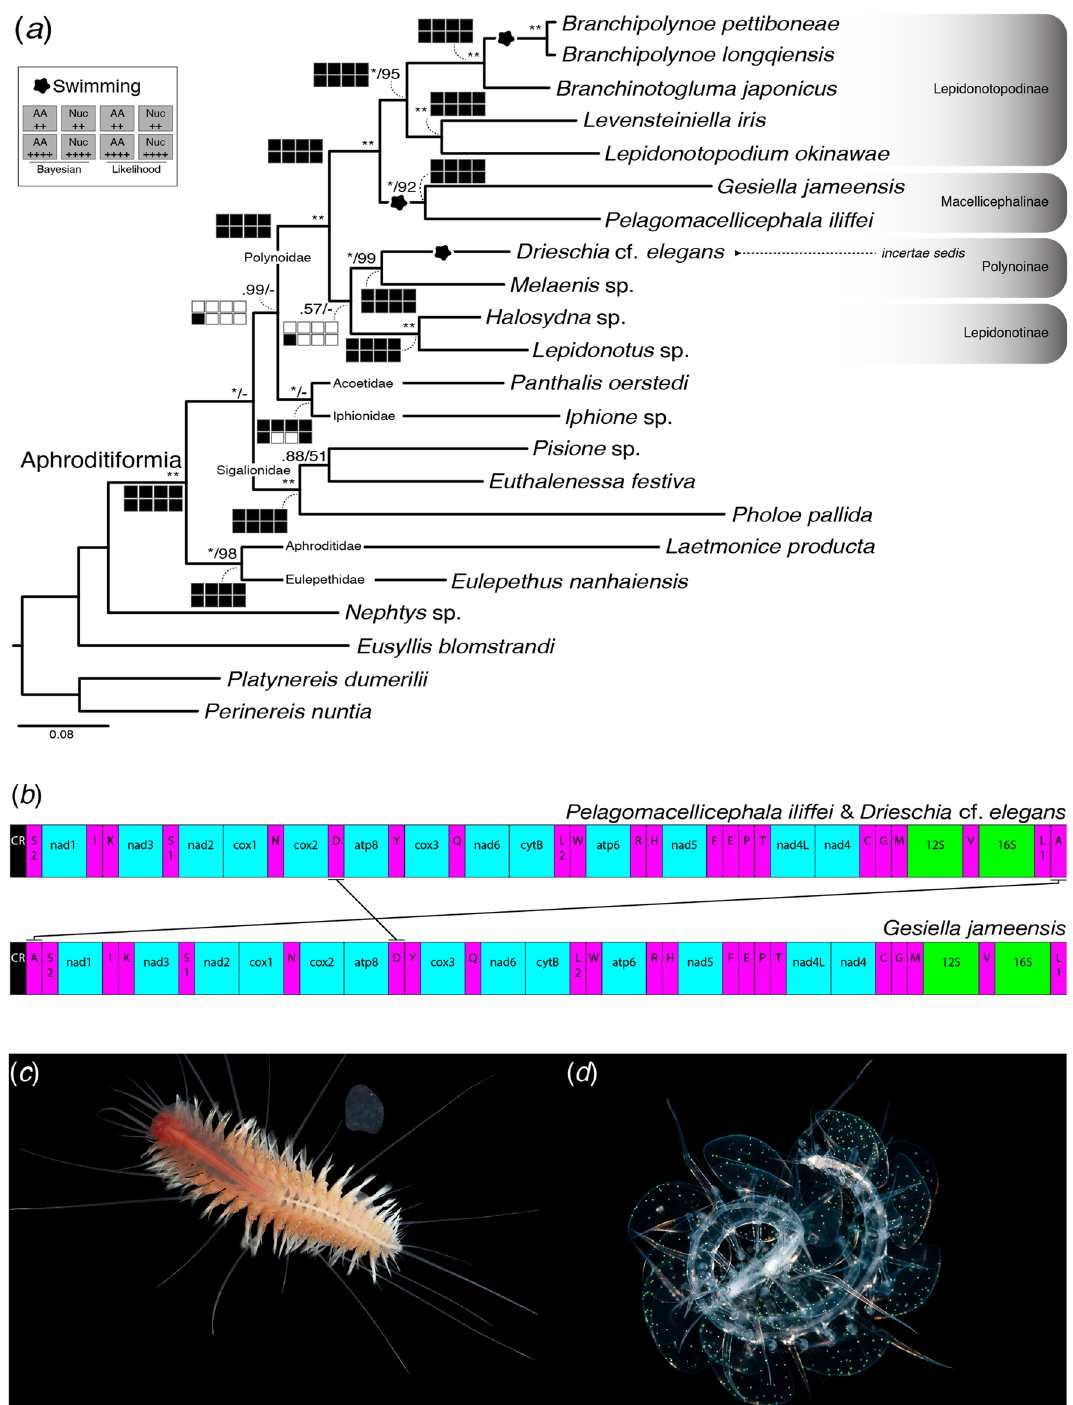
Figure 1. Mitogenomic analyses of Aphroditiformia. ( a ) Mitogenome relationships of Aphroditiformia based on the concatenated dataset of 13 protein coding genes translated into AA + 12S + 16S + 18S + 28S. Tree topology based on the Bayesian analysis (BA) of the dataset. Only nodal support above BPP = 0.5 and MLB = 50 are displayed. Nodes not recovered across analyses or with support lower than BPP = 0.5 and MLB = 50 are represented by a dash (–). Asterisks (*) denote BPP = 1.0 or MLB = 100. “Navajo rugs” indicate recovered (black squares) and unrecovered (white squares) nodes for each of the datasets across both BA and ML. Abbreviations: AA++, 13 PCGs translated into AA + 12S + 16S; AA++++, 13 PCGs translated into AA + 12S + 16S + 18S + 28S; Nuc++, 13 PCG (nucleotides) + 12S + 16S; Nuc++++, 13 PCG (nucleotides) + 12S + 16S + 18S + 28S. ( b ) Mitochondrial gene orders across the three newly generated mitogenomes. Gene order of Pelagomacellicephala iliffei and Drieschia cf. elegans follow that of the putative Polynoidae ground pattern. Black lines indicate the location and direction of gene rearrangements as indicated by the software CRExy 63 . Putative location of the control region (CR) is indicated by black filled rectangles, while fuchsia rectangles indicate tRNA’s, turquoise for PCGs and green for mt rRNAs. ( c ) Cave Pelagomacellicephala iliffei. Photo taken by Jørgen Olesen ( d ) Holopelagic cf. Drieschia. Photo courtesy of Linda